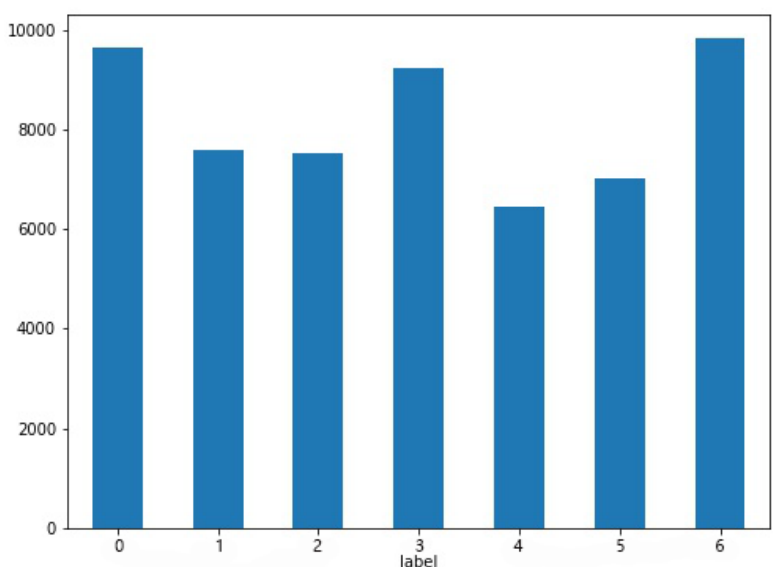
Figure 4. The representation of sample data volume after over-sampling in MELD dataset (where 0–6 in label represents six emotional labels: ‘anger’, ‘disgust’, ‘fear’, ‘joy’, ‘neutral’, ‘sadness’,